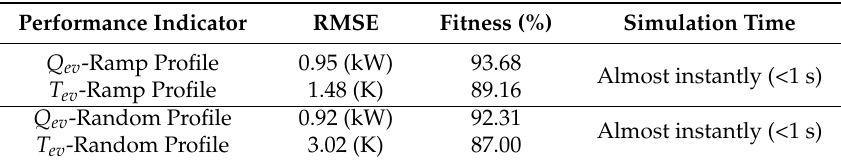
Table 6. Performance of the fuzzy based evaporator